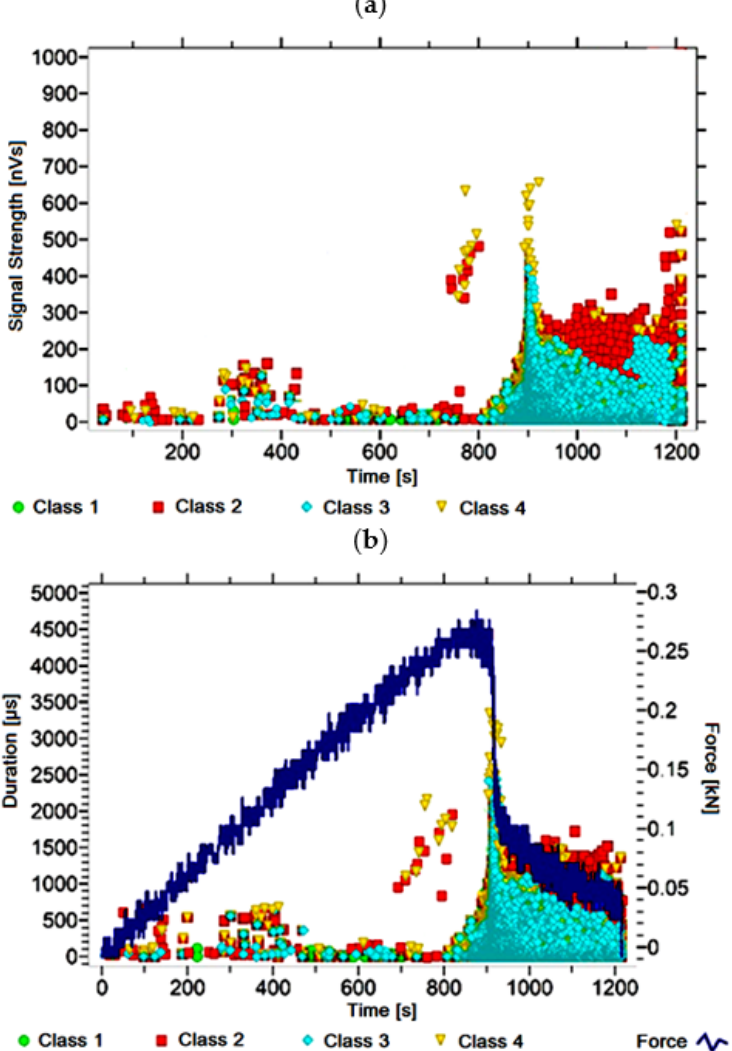
Figure 3. Graphs of acoustic emission signals for an exemplary sample of A 2 series: ( a ) signal strength over time; ( b ) distribution of the duration of the signals over time with the force increment curve.